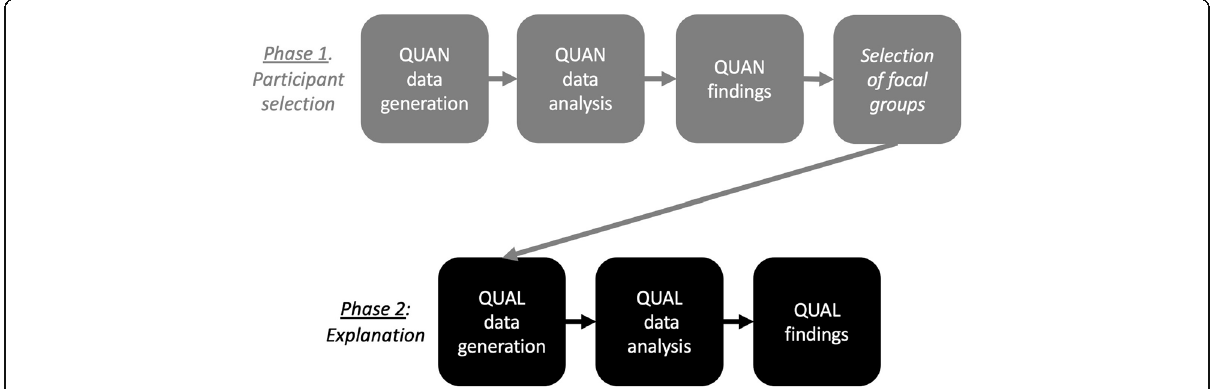
Fig. 3 Mixed-methods sequential design, including participant selection followed by